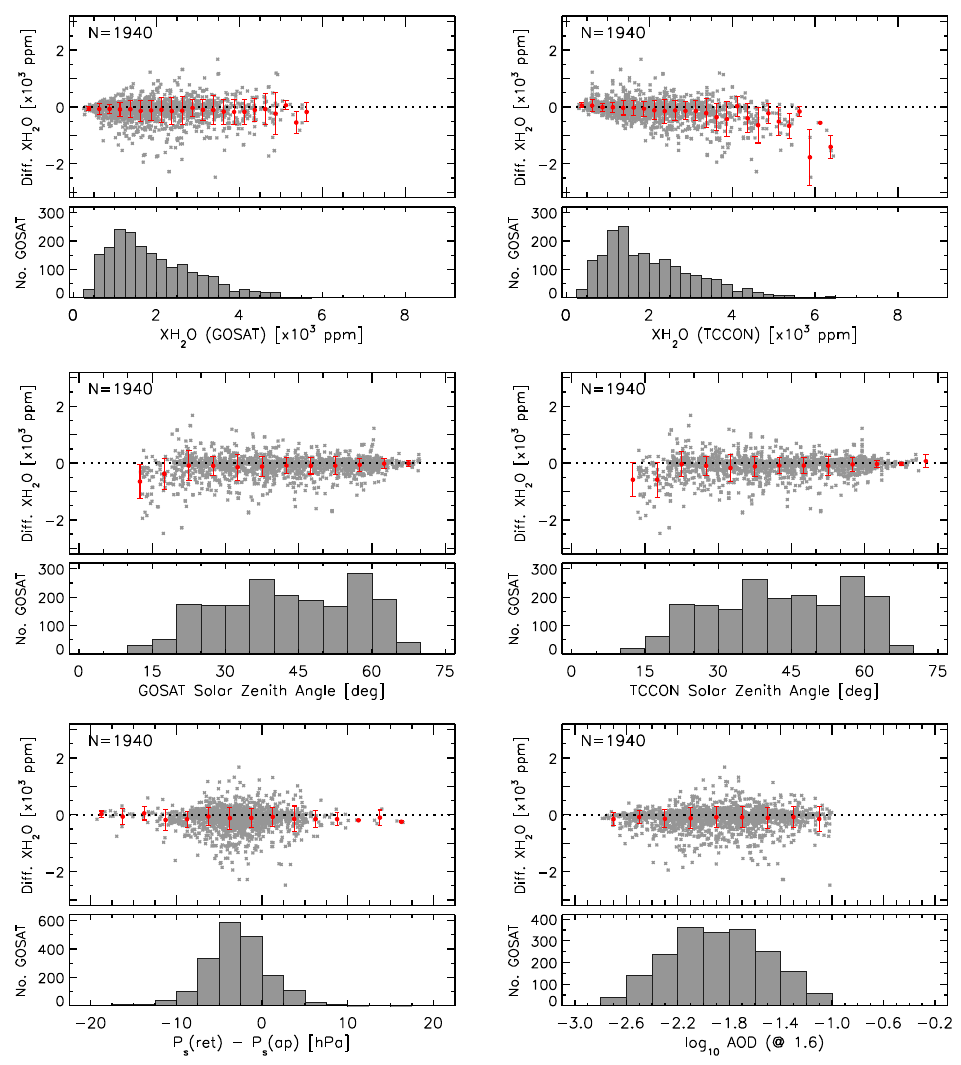
Figure 10. Correction of Figure 10 in [1]. Evolution of the XH 2 O absolute differences (GOSAT − TCCON) for the nominal coincidence criteria ( ± 1 ◦ latitude/longitude and ± 30min), as a function of geophysical and retrieval parameters: the TANSO-FTS and TCCON XH 2 O ( top row ), the solar zenith angle values for GOSAT and TCCON ( middle row ), the difference between the retrieved and the a priori values for the surface pressure ( bottom left ) and the aerosol optical depth at 1.6 µ m retrieved from the TANSO-FTS spectra ( bottom right ). The corresponding histograms of the number of TANSO-FTS scans are plotted below each panel. The grey dots represent the single-scan differences; the red symbols with “error bars” show the average value and associated standard deviation within each histogram